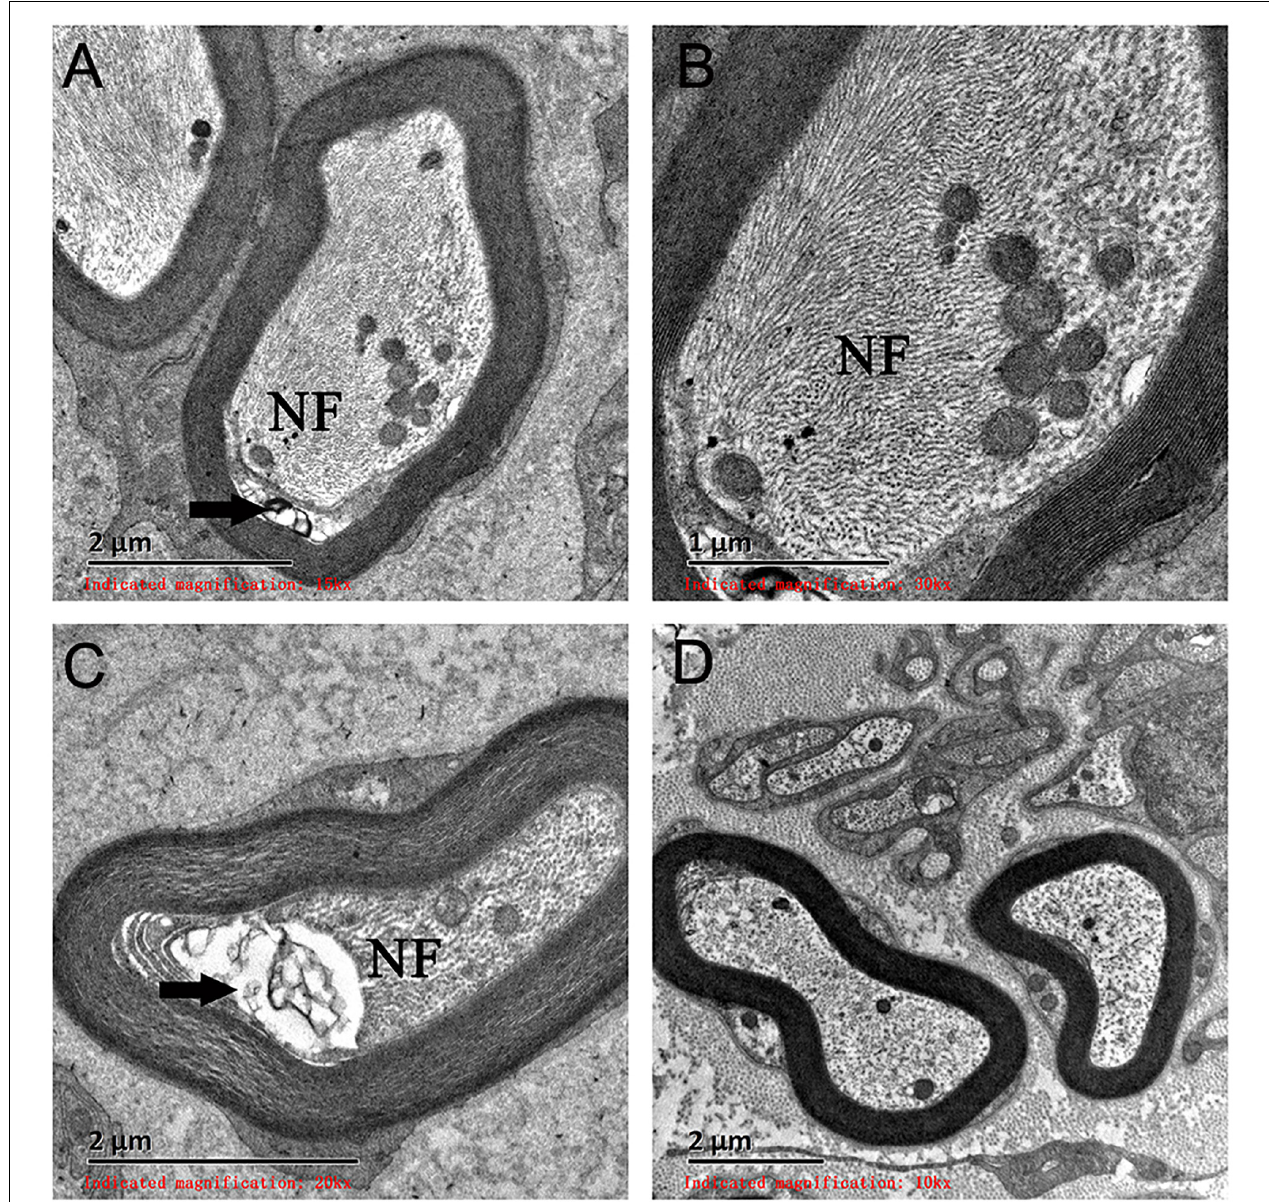
FIGURE 3 | Electron microscopy examination of a giant axon (GA). (A,B) Electron microscopy showed giant axons filled with closely packed neurofilaments. (C) Neural axons were mildly atrophied (arrow) and separated from the myelin sheath. (D) A normal neural axon. NF,